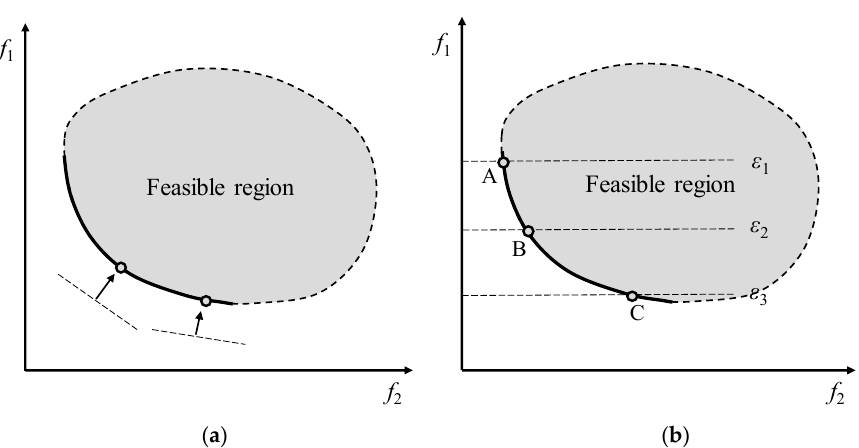
Figure 8. Schematic diagram of the weighted sum method ( a ) and the ε -constraint method ( b